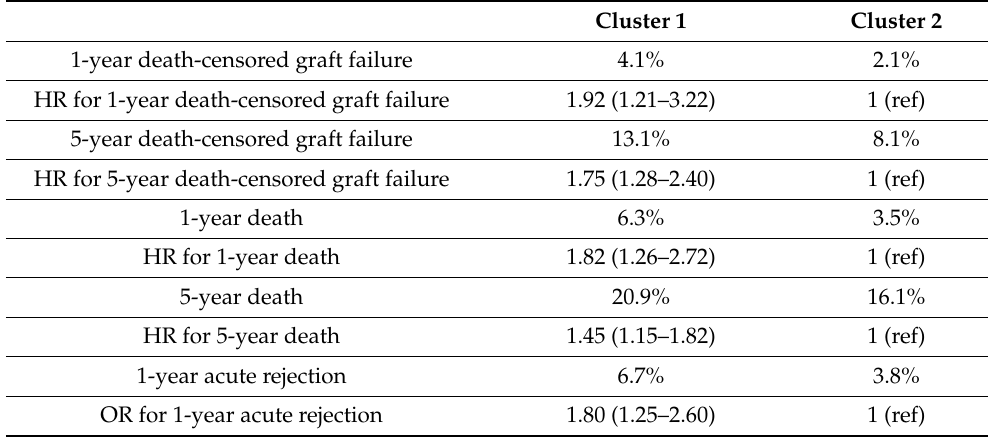
Table 2. Post-transplant outcomes according to the clusters of functionally disabled kidney trans- plant